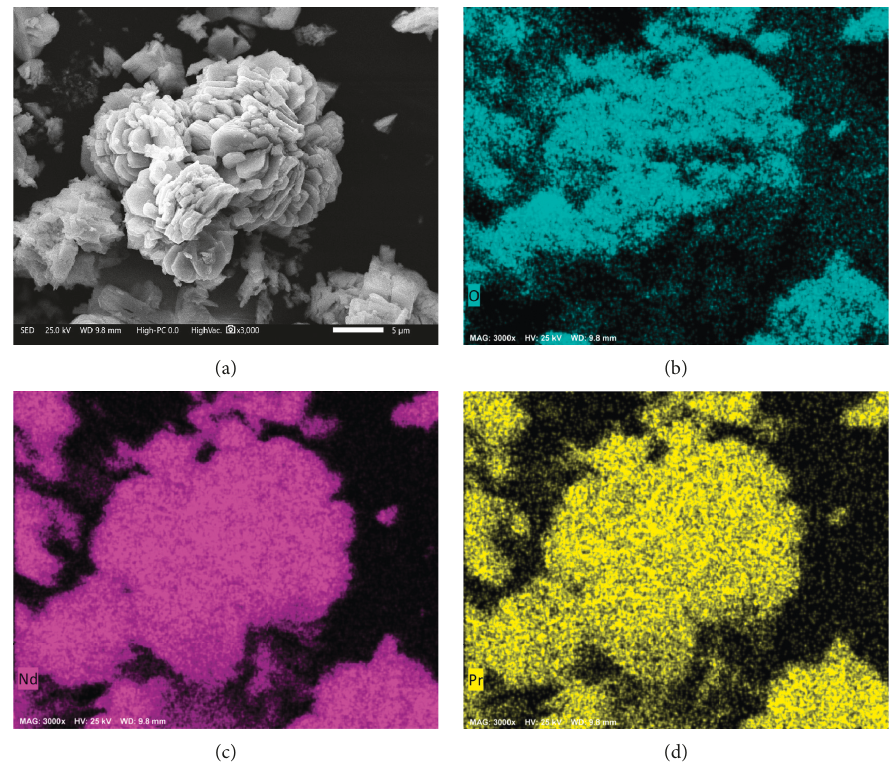
Figure 3: Element mapping of the rare earth oxides recovered from permanent magnets.